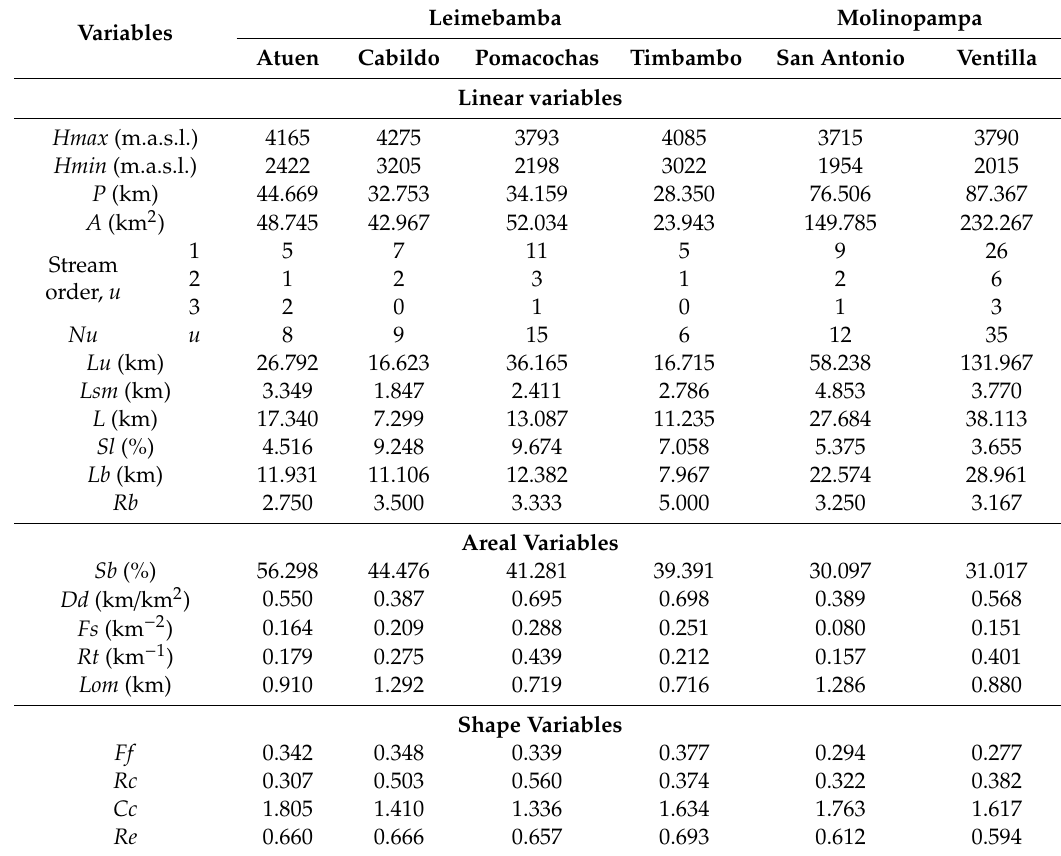
Table 4. Linear, areal, and shape variables of the four HAL-MWs in Leimebamba and two HAL-MWs in Molinopampa (Amazonas,